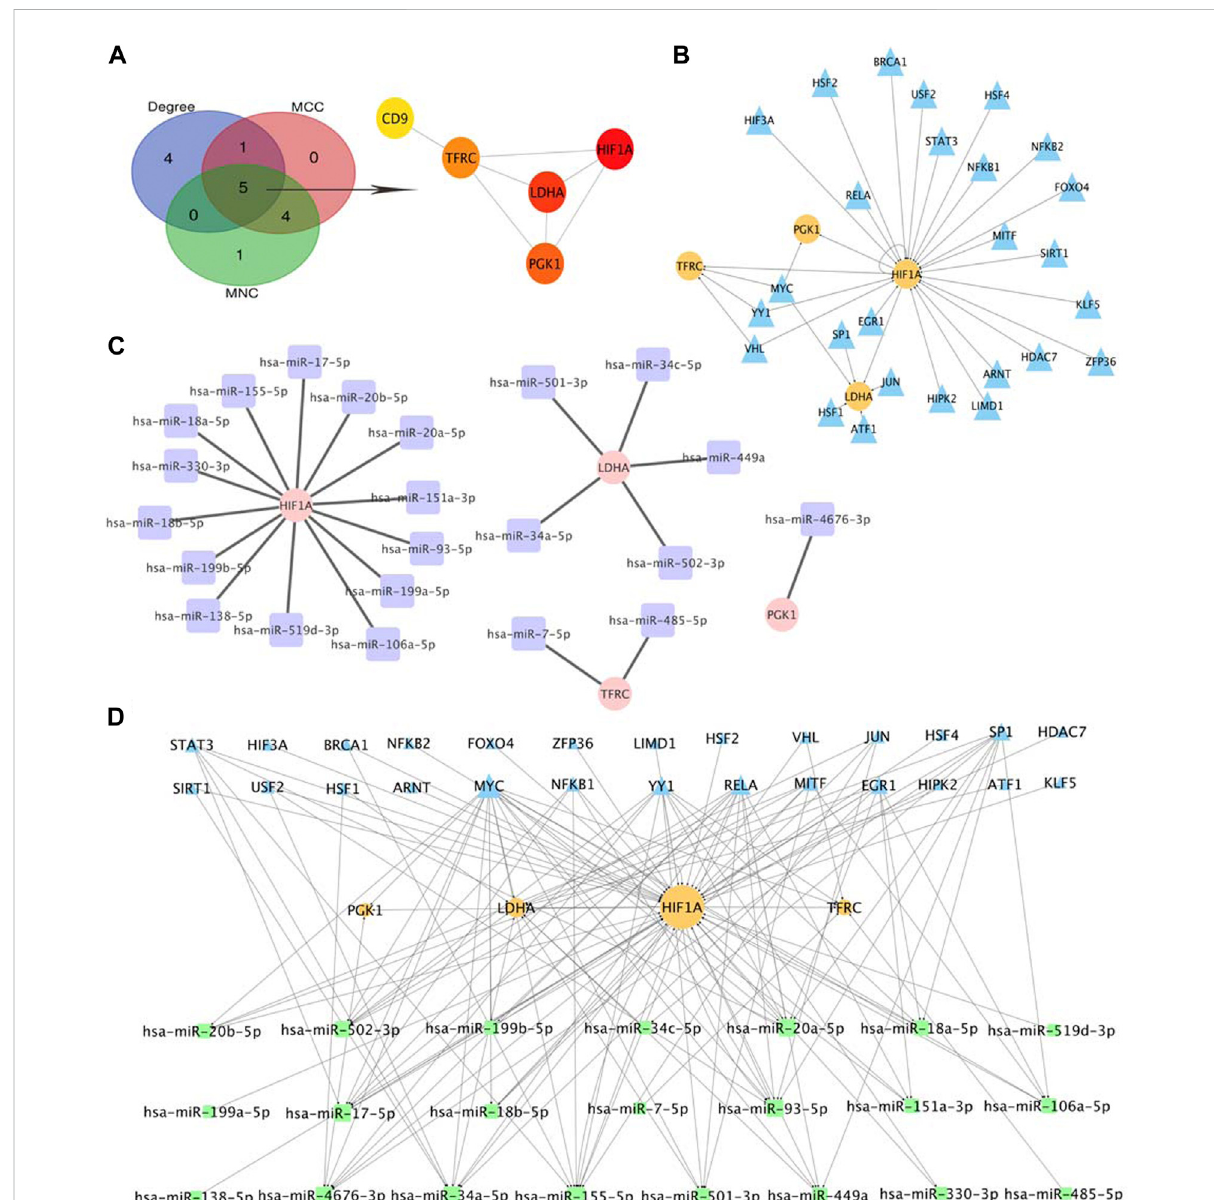
Selection of Hub Genes and Analysis of TF-miRNA-Hub Gene Network. (A) hub gene correlated with OE. (B) predicted TFs of hub gene, the circles indicate target genes and the triangles indicate predicted TFs. (C) predicted miRNAs of hub gene, the circles indicate target genes and the squaresindicatepredictedmiRNAs. (D) .ConstructionofTF-miRNA-hubgenenetwork,thesquaresindicatepredictedmiRNAs,thetrianglesindicate predicted TFs and the circles indicate target